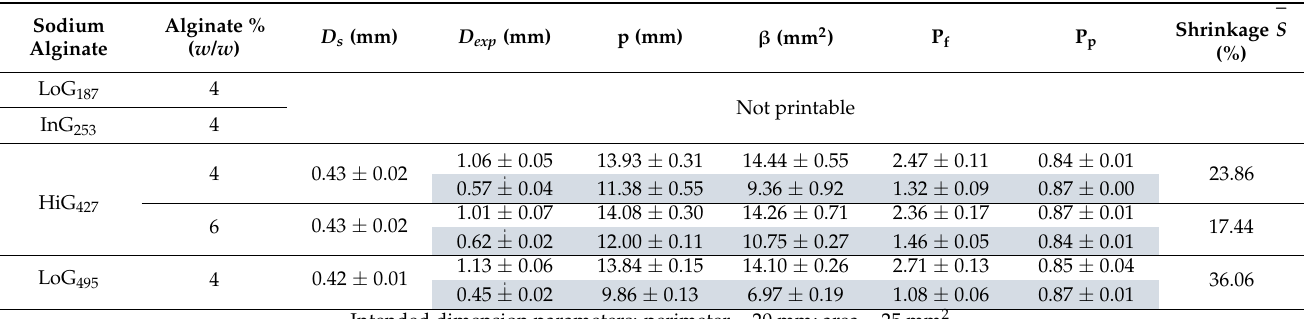
Table 4. Printability parameters for uncross-linked (not shady) and cross-linked (shady) alginate imprint structures ( n = 3 per